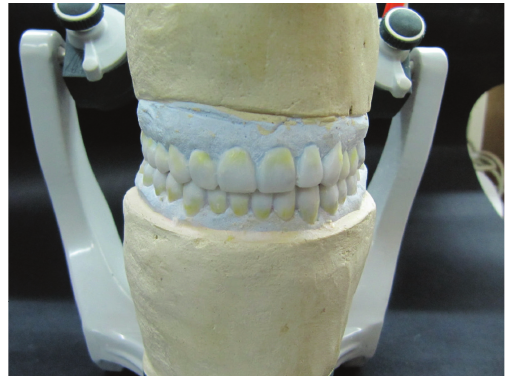
Figure 6: Diagnostic wax-up.